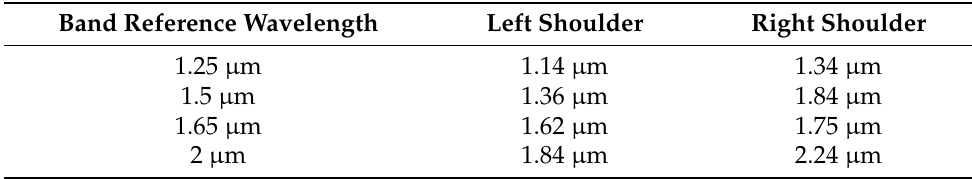
Table A1. Endpoints (left and right shoulder) for the computation of continuum-removed spectra of water ice absorption bands.